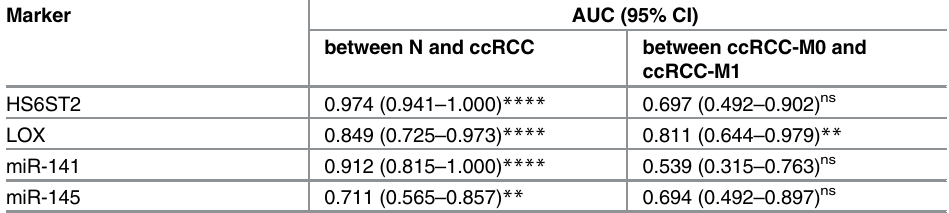
Table 3. ROC analysis to predict the diagnostic impact of the miRNA and mRNA target expression.